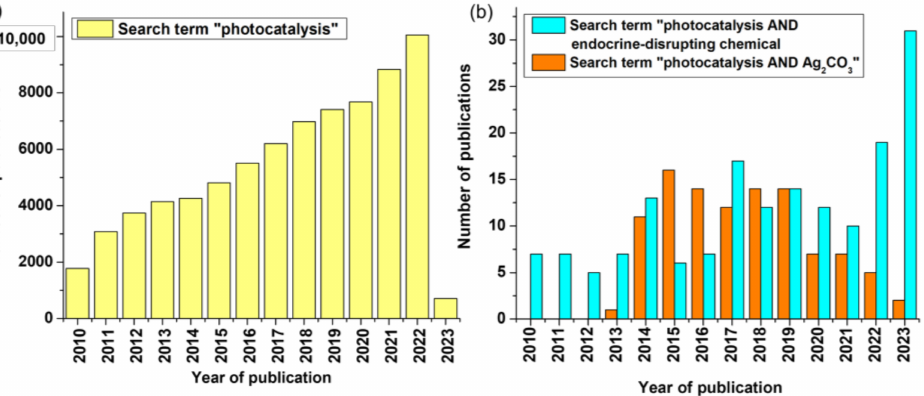
Figure 1. ( a , b ) Annual publications of photocatalysis (Scopus search system accessed in December 2022; search terms “photocatalysis”, “photocatalysis AND endocrine disrupting chemical”, and “photocatalysis AND Ag 2 CO 3 ” from 2010 to